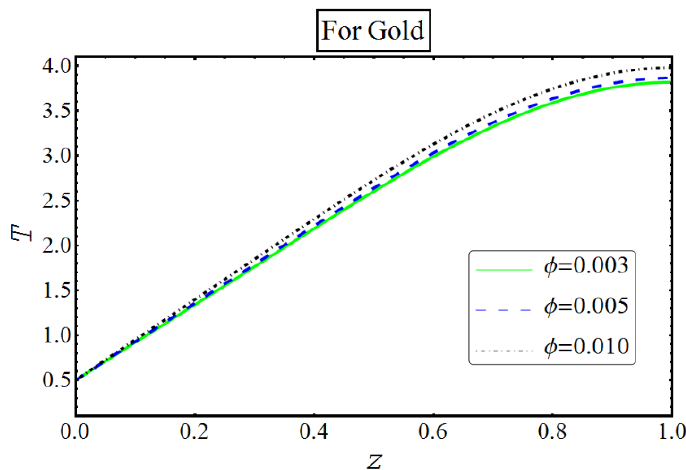
Figure 22. Temperature effects of concentration particles.